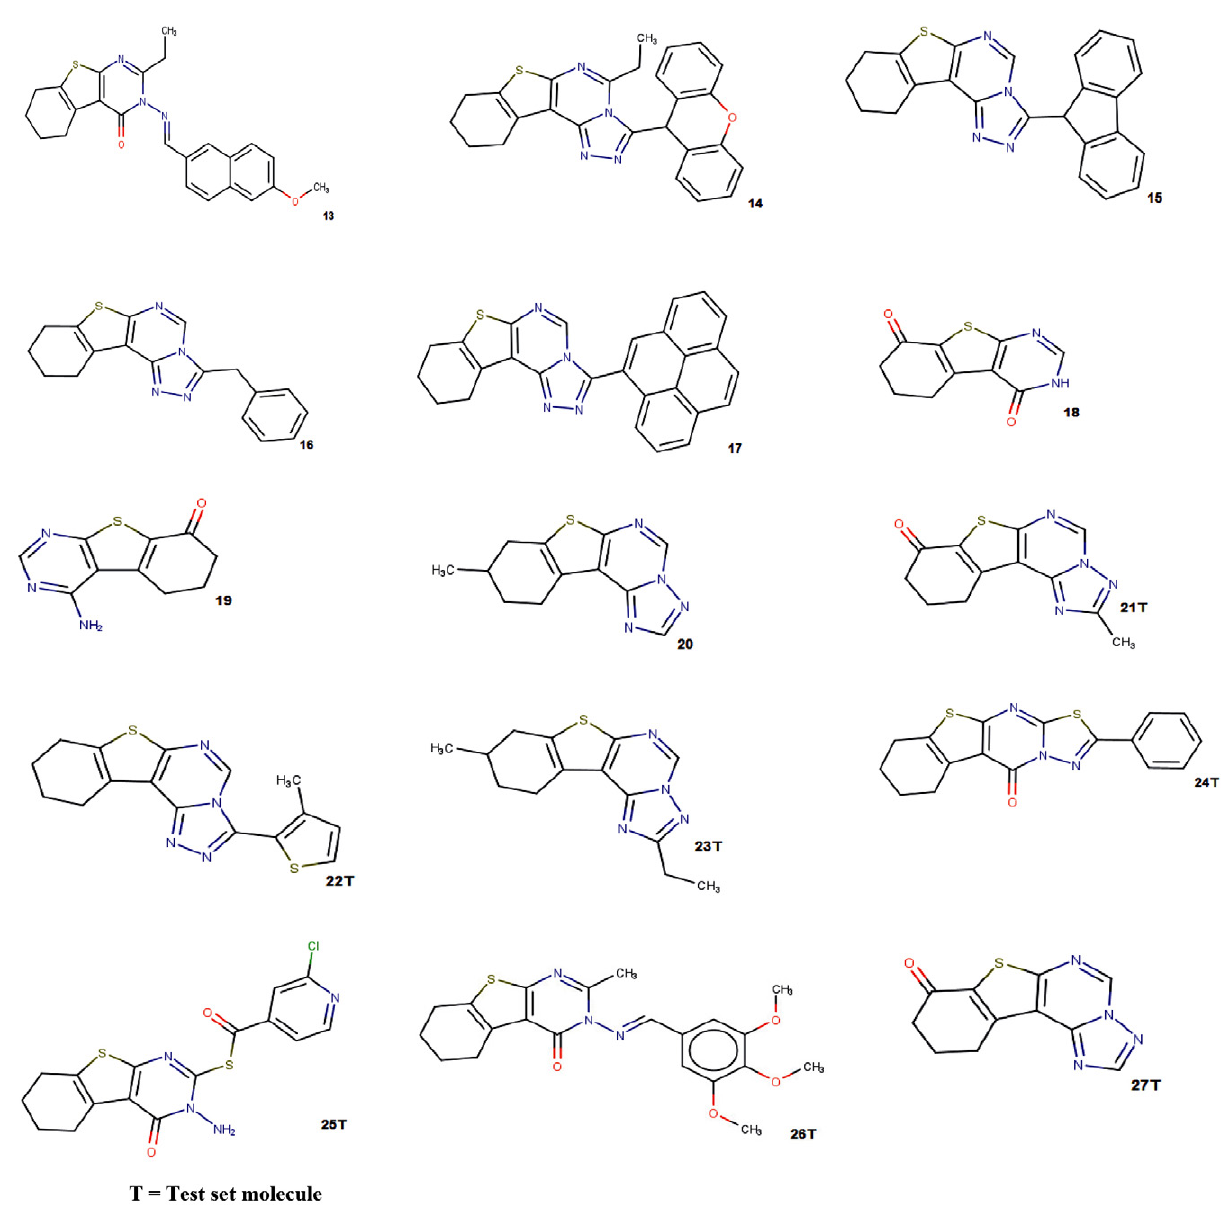
Fig. 1: Structure of thienopyrimidine